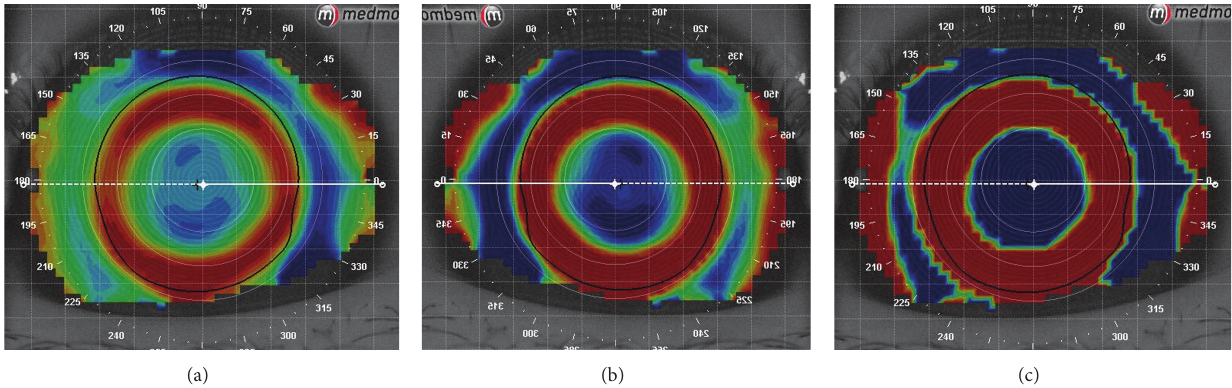
Figure 3: The “inversion arc” became obvious when the “step size” decreased. (a) Step size is 1.00 D. (b) Step size is 0.50 D. (c) Step size is 0.10